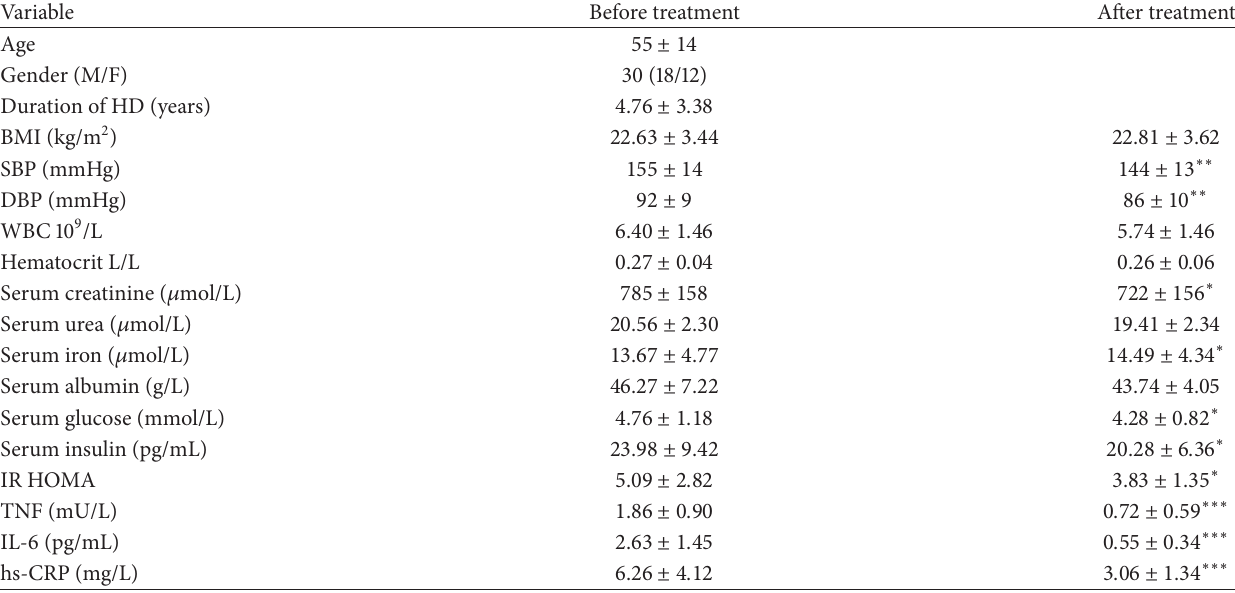
Table 1: The baseline characteristics of study participants and responsiveness to milled seed mixture after twelve